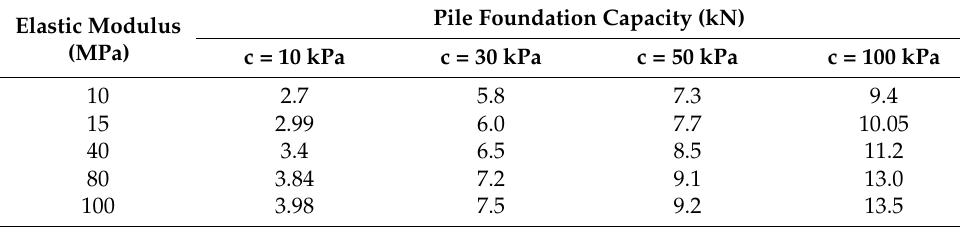
Table 9. Pile foundation capacity in relation to Young’s modulus of soil for CHSB 1